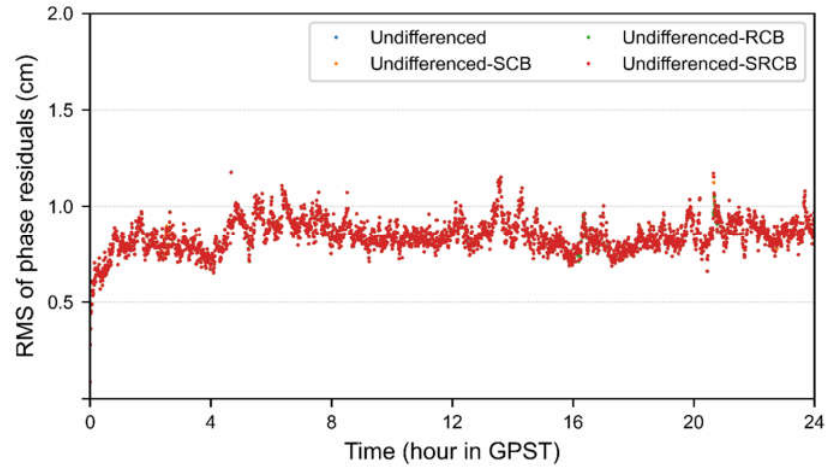
Figure 3. Time series of RMS of the phase residuals for different models on DOY 031.